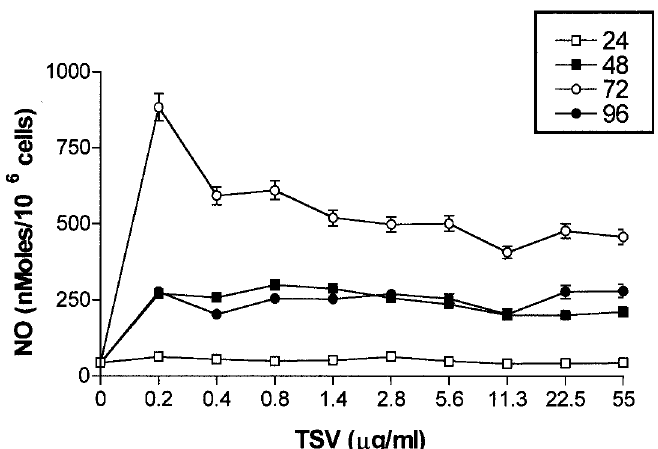
FIG. 3. NO production. Peritoneal macrophages were obtained and stimulated in vitro as described in Fig. 1. NO levels were detected by the Griess colorimetric reaction. Each point represents the mean ± standard deviation value of samples from five experiments in different groups of five mice.